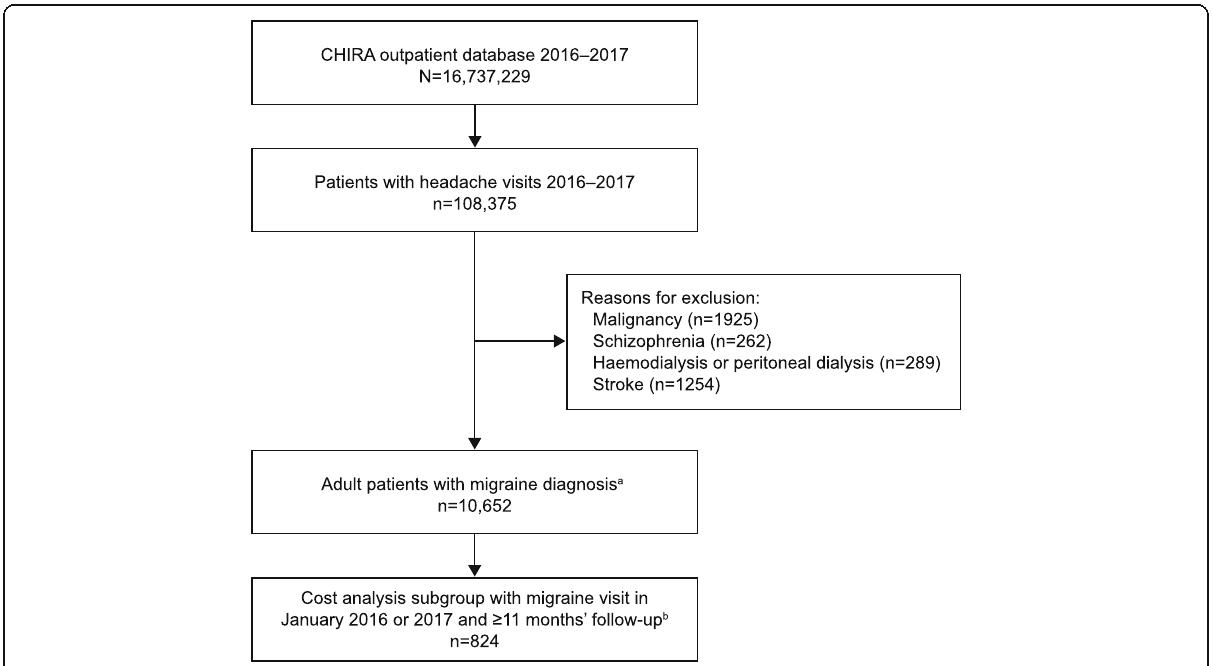
Fig. 1 Patient selection. a Migraine diagnosis by ICD-10 code ( ICD-10 G43.0, G43.1, G43.2, G43.3, G43.8, G43.9) supplemented by physician Chinese characters descriptions. b Patients with a migraine-related outpatient visit in January 2016 or January 2017 and with ≥ 11 months of follow-up were included in the outpatient cost analysis. CHIRA: China Health Insurance Research Association; ICD : International Statistical Classification of Diseases and Related Health